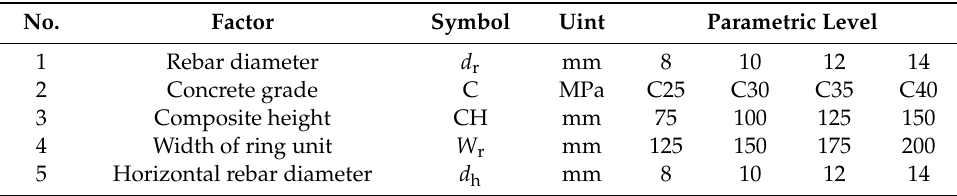
Table 3. List of factors in the bearing capacity analysis.